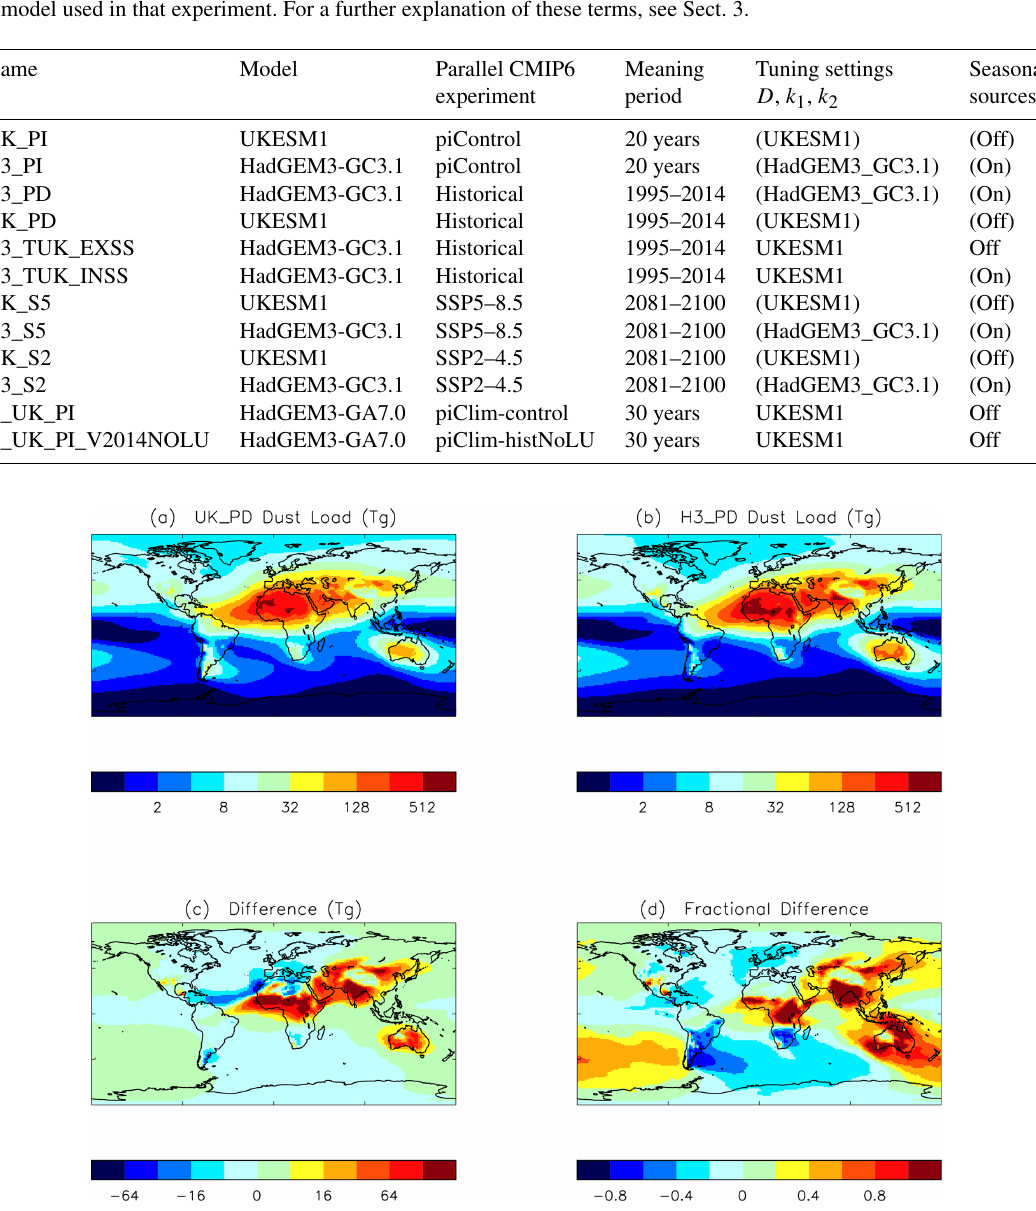
Figure 1. Dust load (Tg) from H3_PD, UK_PD, difference and fractional difference.